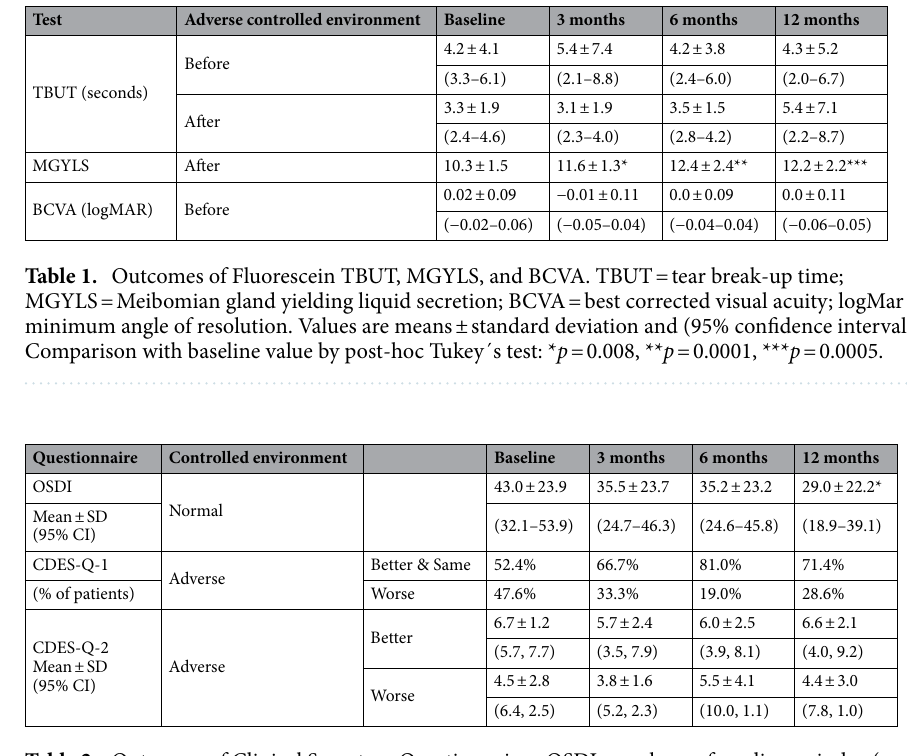
Table 2. Outcomes of Clinical Symptom Questionnaires. OSDI = ocular surface disease index (range: 0–100); CDES-Q-1 = change in dry eye symptoms questionnaire 1 (range: better, worse, or the same); CDES-Q-2 = change in dry eye symptoms questionnaire 2 (range: 0–10); CI = confidence interval; SD = standard deviation. *Comparison with baseline value, p = 0.003, post-hoc Tukey´s test. No significant differences were found in CDES-Q-1 among visits. OSDI outcomes were measured under normal controlled environment, and CDES-Q outcomes were measured after 2 h of adverse controlled environmental